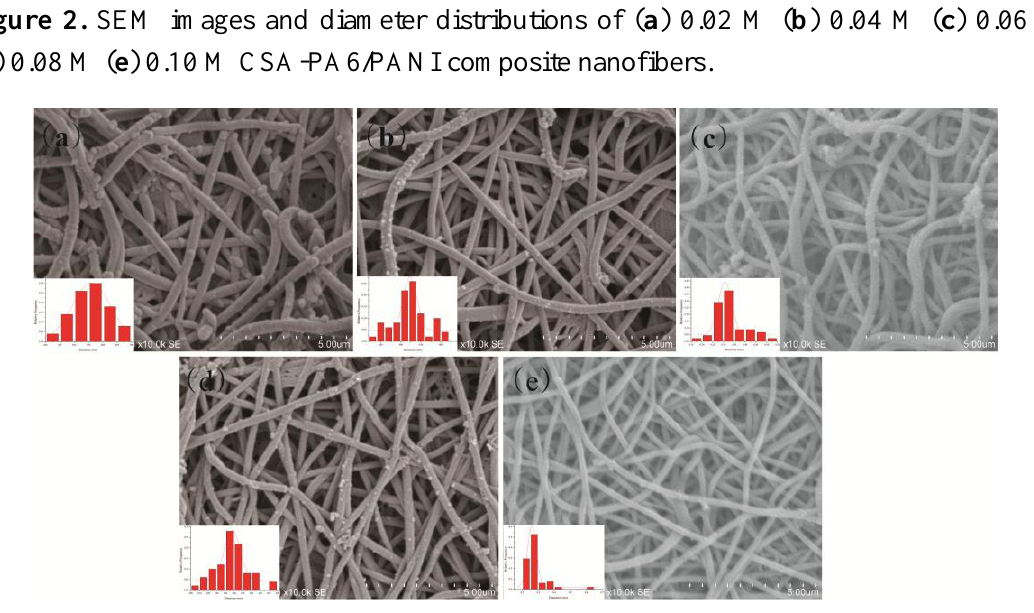
Figure 2. SEM images and diameter distributions of ( a ) 0.02 M ( b ) 0.04 M ( c ) 0.06